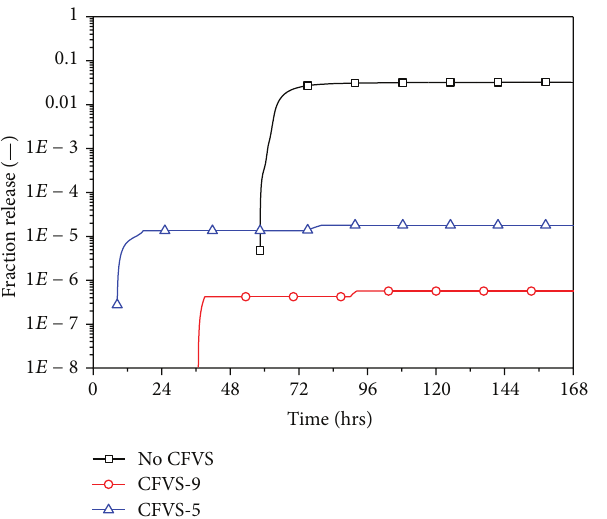
Figure9:ComparisonoffractionalreleaseofnoblegasinLBLOCA.